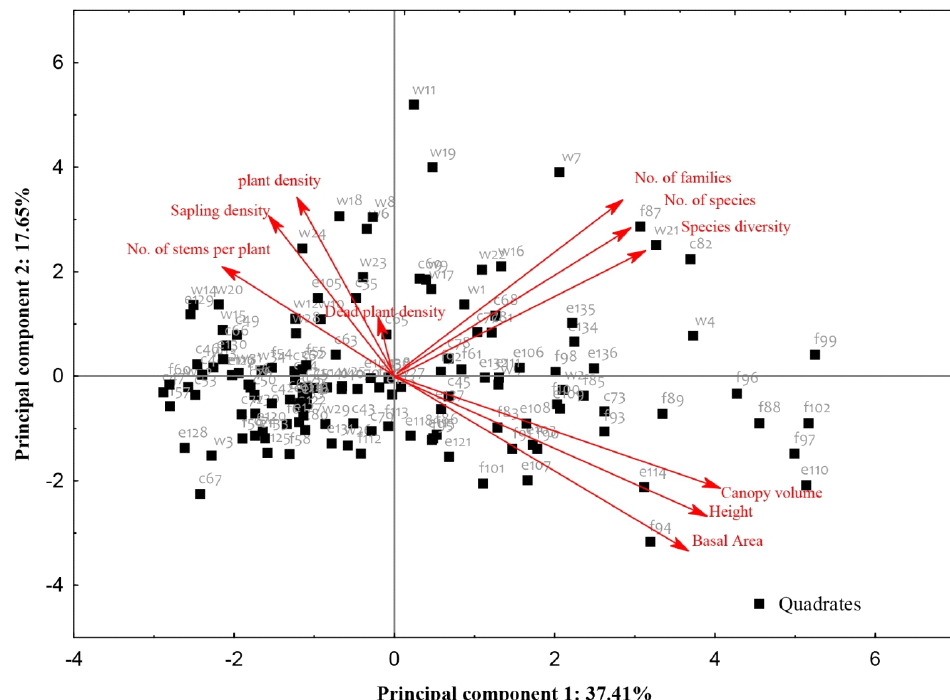
Fig. 3: PCA bi-plot of plots in selected soil types, Mapungubwe Cultural Landscape, northwestern Limpopo province, South Africa Notes: The coded numbers represent all plots sampled in the four soil strata defined in Table 2. w = strata 1(western); c=strata 2(central); f=strata 3(floodplain) and e=strata 4(eastern).